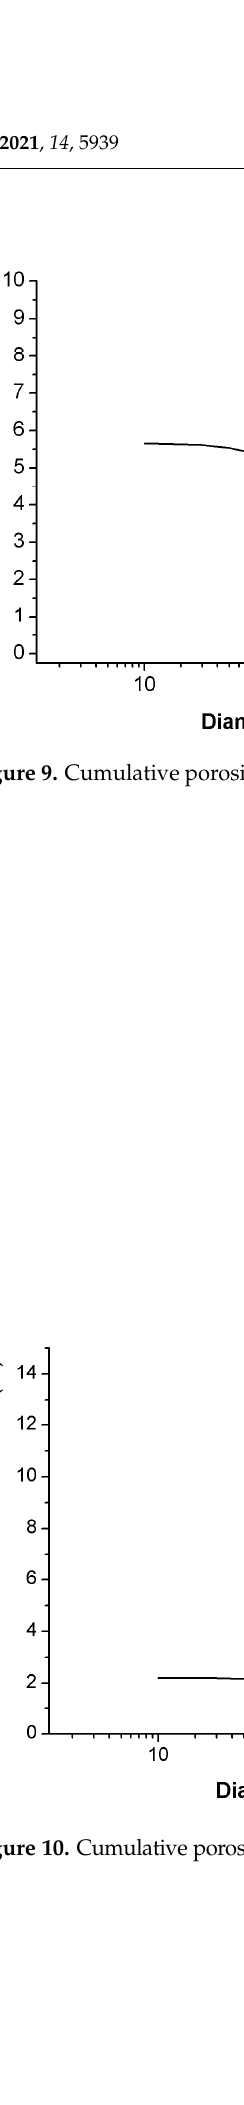
Figure 11. Example of the 3D visualization of sample NM. On the left , the gray scale reconstruc- tion cylinder is visible. On the right , a section of the cylinder in false color is shown. The pores (violet), aggregate (light brown) and the binder (white) are highlighted. (For interpretation of the references to color in this figure the reader is referred to the web version of this article). 3.3. Comparison of MIP and µCT Porosity Results Some general statements should be considered before comparing the results of MIP and µCT analyses. It is important to take into account that the investigated techniques measure pore sizes in two slightly different ranges. The µCT technique allows evaluating the porosity of air voids with a diameter over 10 µm, while the MIP technique evaluates pores (throats) with a diameter less than 90 µm. Thus, the measuring ranges overlap between 10 µm and 90 µm. Ink bottle effects in MIP could result in larger pores being counted in the smaller pore sizes. Thus, it can be expected that the total porosity of MIP is correct if we assume that the pore network of the mortars is connected by throats of a 3.7-nm minimum, which is the lowest limit investigated by the MIP technique. With the used configuration, µCT cannot determine pore sizes in the micron and submicron ranges, but the pore and air